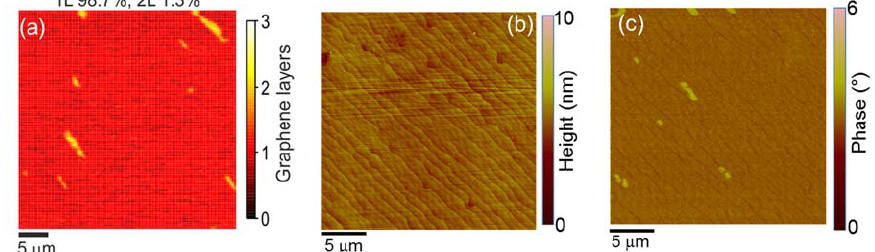
Figure 3 ( a ). Reflectance map of as ‐ grown EG collected on a 30  m × 30  m sample area. The red Figure 3. ( a ) Reflectance map of as-grown EG collected on a 30 µ m × 30 µ m sample area. The red contrast background is associated with 1 L graphene (98.7% of the total area) and the yellow elongated patches to 2 L graphene (1.3% of the total area). ( b ) AFM morphology and ( c ) phase contrast map on a 30 µ m × 30 µ m sample area. The small elongated patches with higher phase contrast correspond to 2 L EG. Images adapted with permission from Ref. [21], copyright Wiley